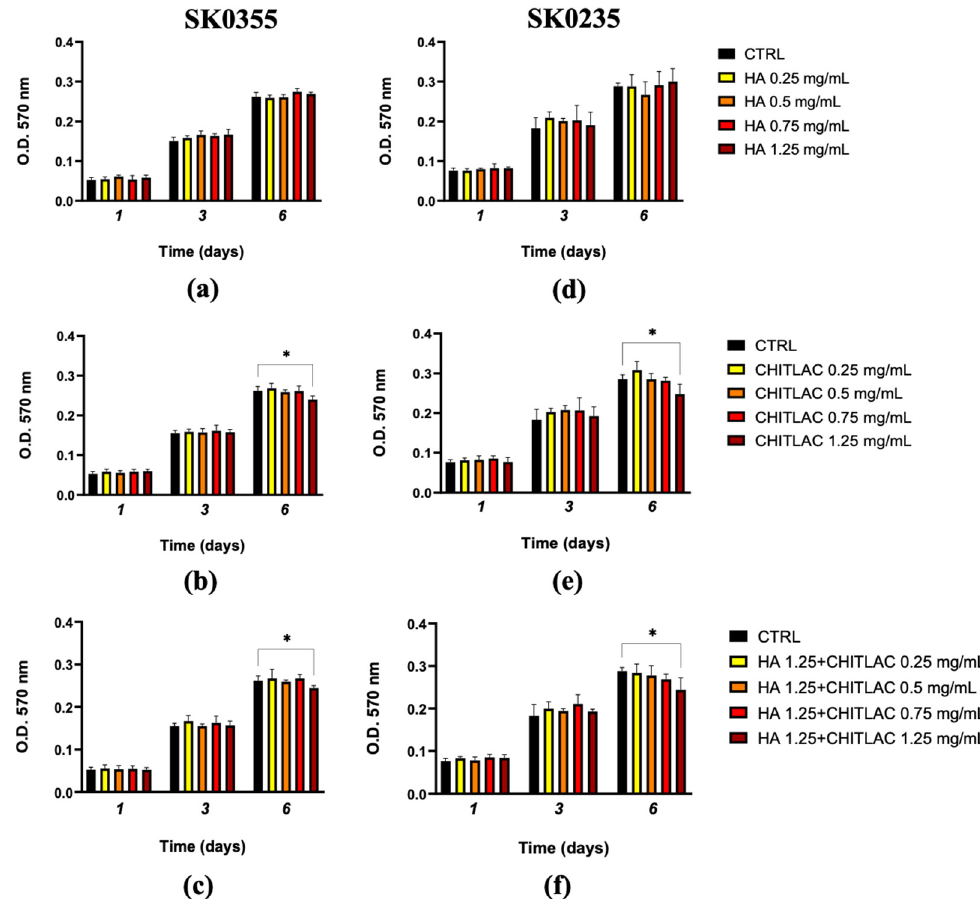
Figure 4. Time-dependent effects of HA, CTL and their mixture on human dermal fibroblast viability. In total, 7000/cm 2 SK0355 (from a 30-year-old woman) and SK0235 (from a 54-year-old woman) cells were seeded in 96-well culture plates and exposed to the stated concentrations of HA ( a , d ), CTL ( b , e ), or different combinations of HA-CTL mixture ( c , f ) for various exposure durations. The MTT test was conducted 1-, 3- and 6-days following treatment. The results are presented as mean ± SE of three independent experiments. The unpaired Student’s t -test was used to determine statistical differences. * p < 0.05 when compared to untreated cells.